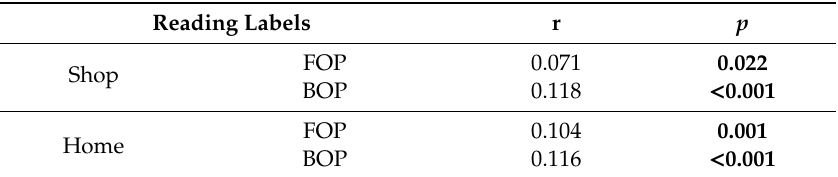
Table 4. Correlation coe ffi cients between the importance attached to salt content information on food packaging and reading labels (the share of food products for which the respondent reads FOP or BOP labels in the shop or at